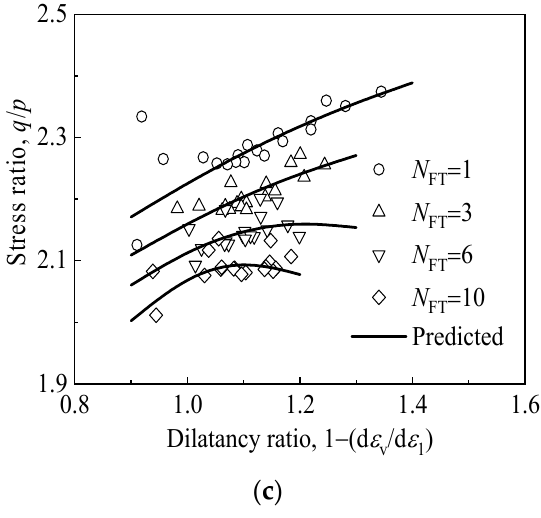
Figure 3. Relationship between the stress ratio and dilatancy ratio of CGS corresponding to different numbers of FTCs and confining pressures: ( a ) σ 3 = 30 kPa, ( b ) σ 3 = 60 kPa, and ( c ) σ 3 = 90 kPa.